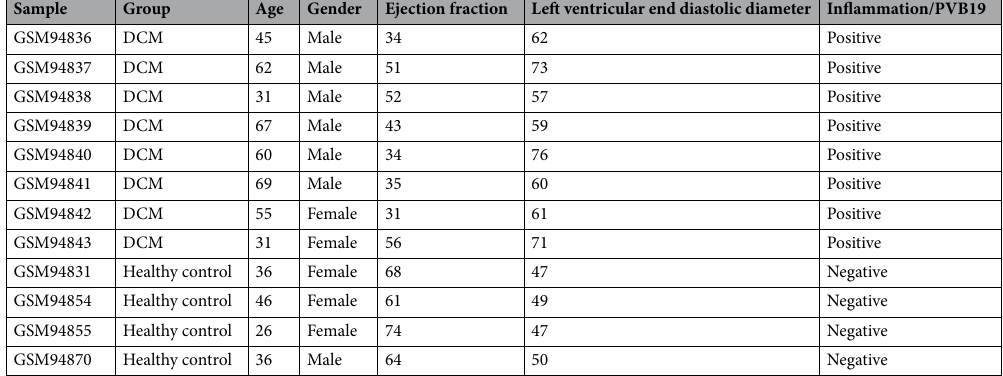
Table 4. Clinical information for the GSE4172